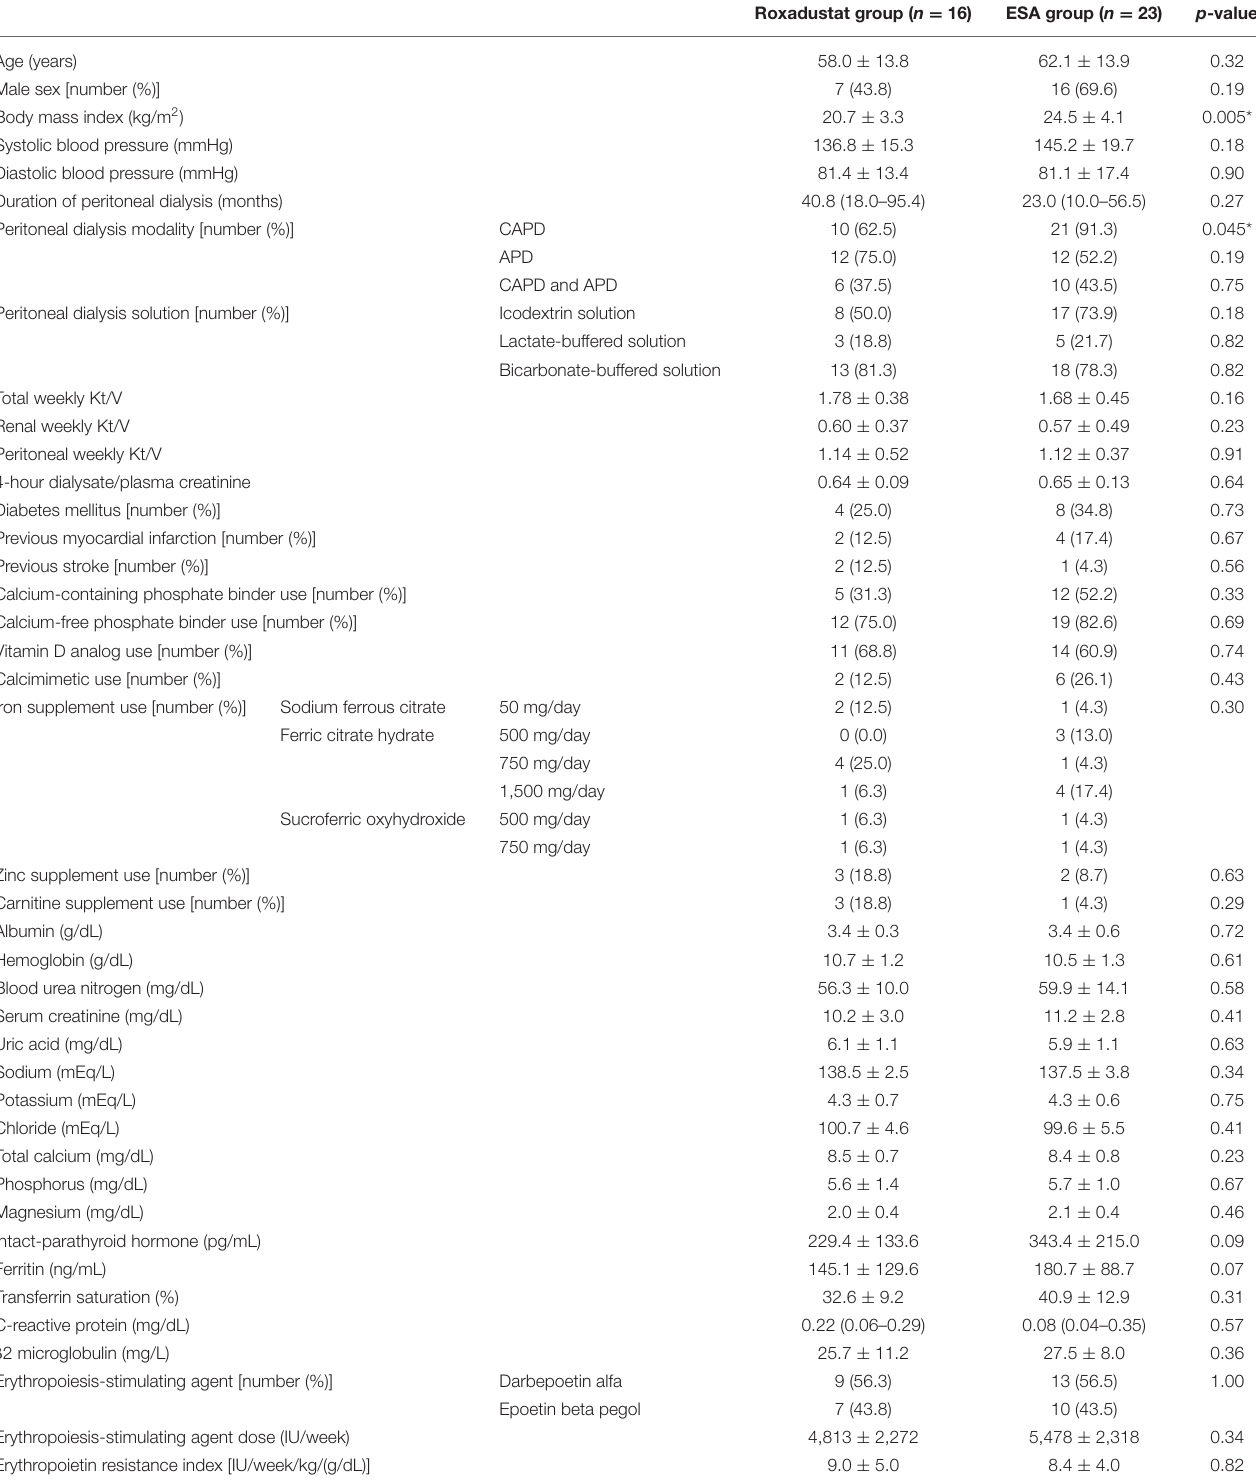
TABLE 1 | Baseline patient